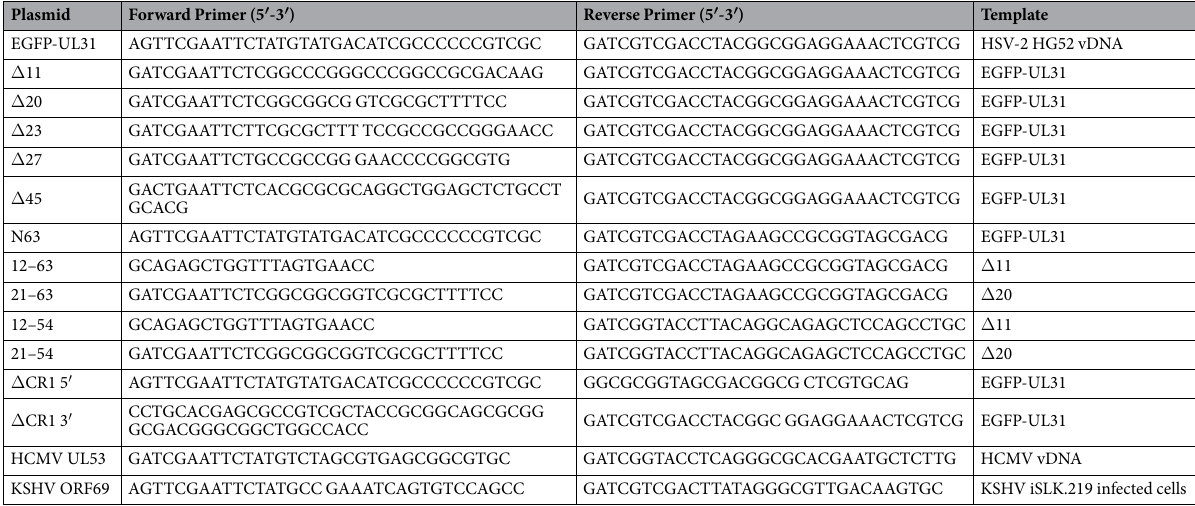
Table 1. Primers used to construct UL31 expression